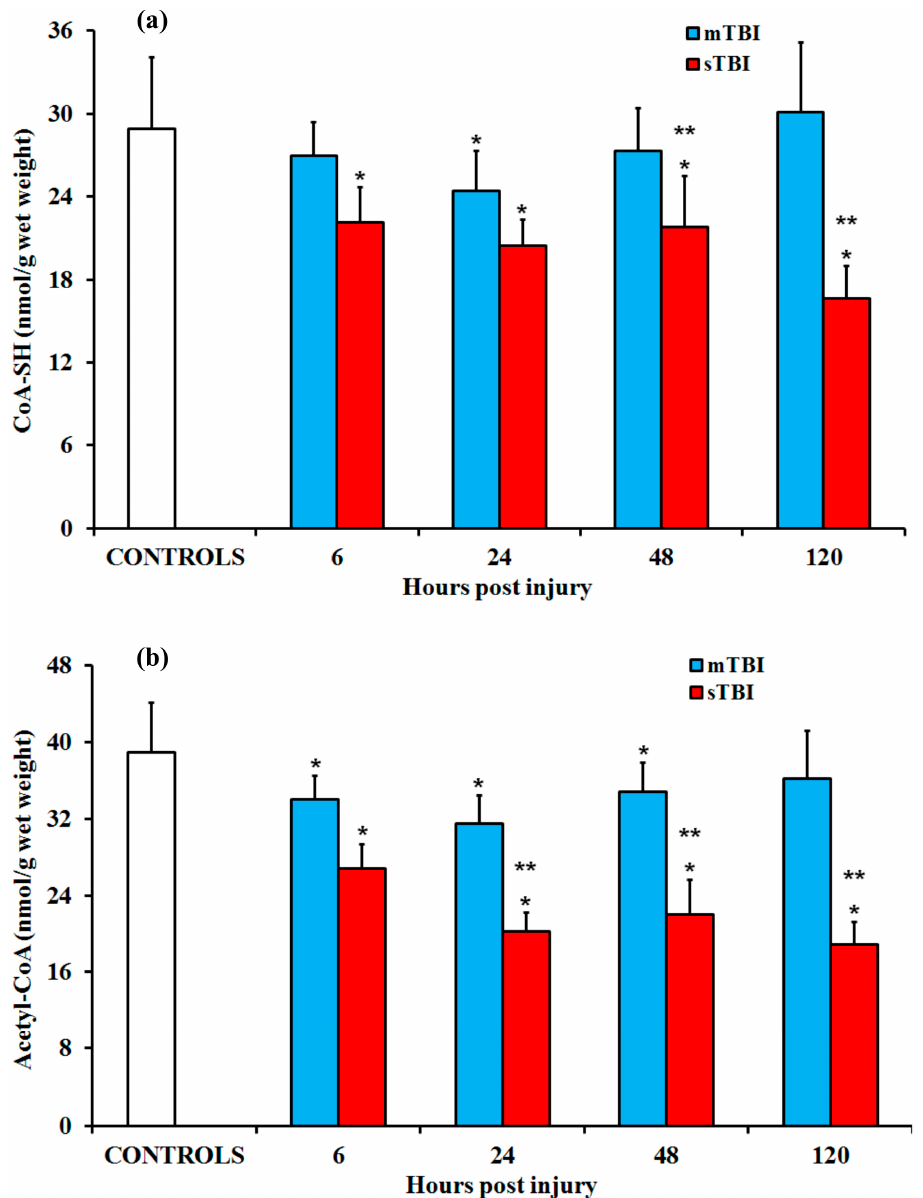
Figure 11. Changes in the concentrations of ( a ) the free coenzyme A (CoA-SH) and ( b ) acetyl-CoA in the brain tissue homogenates of rats receiving TBIs of di ff erent severities (an mTBI or sTBI) at various times post-injury. Values are the mean of six animals. Standard deviations are represented by vertical bars. The two compounds were measured by HPLC, as described in Materials and Methods. * significantly di ff erent from the controls, p < 0.05. ** significantly di ff erent from the corresponding time of the mTBI rats, p < 0.05.